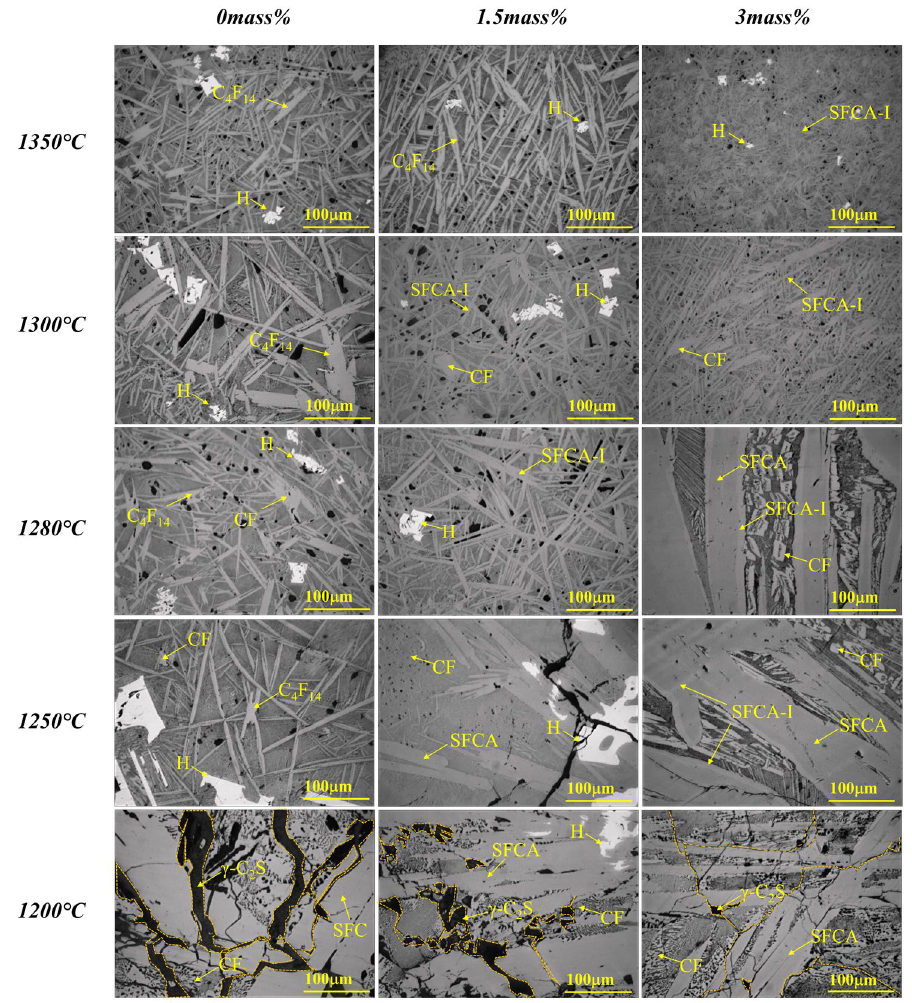
Fe 3+ Si 0 . 66 O 28 ; SFCA- I : Fe 3 + Si 0.66 O 28 ; SFCA-I: 0.04 10.56 0.04 10.56